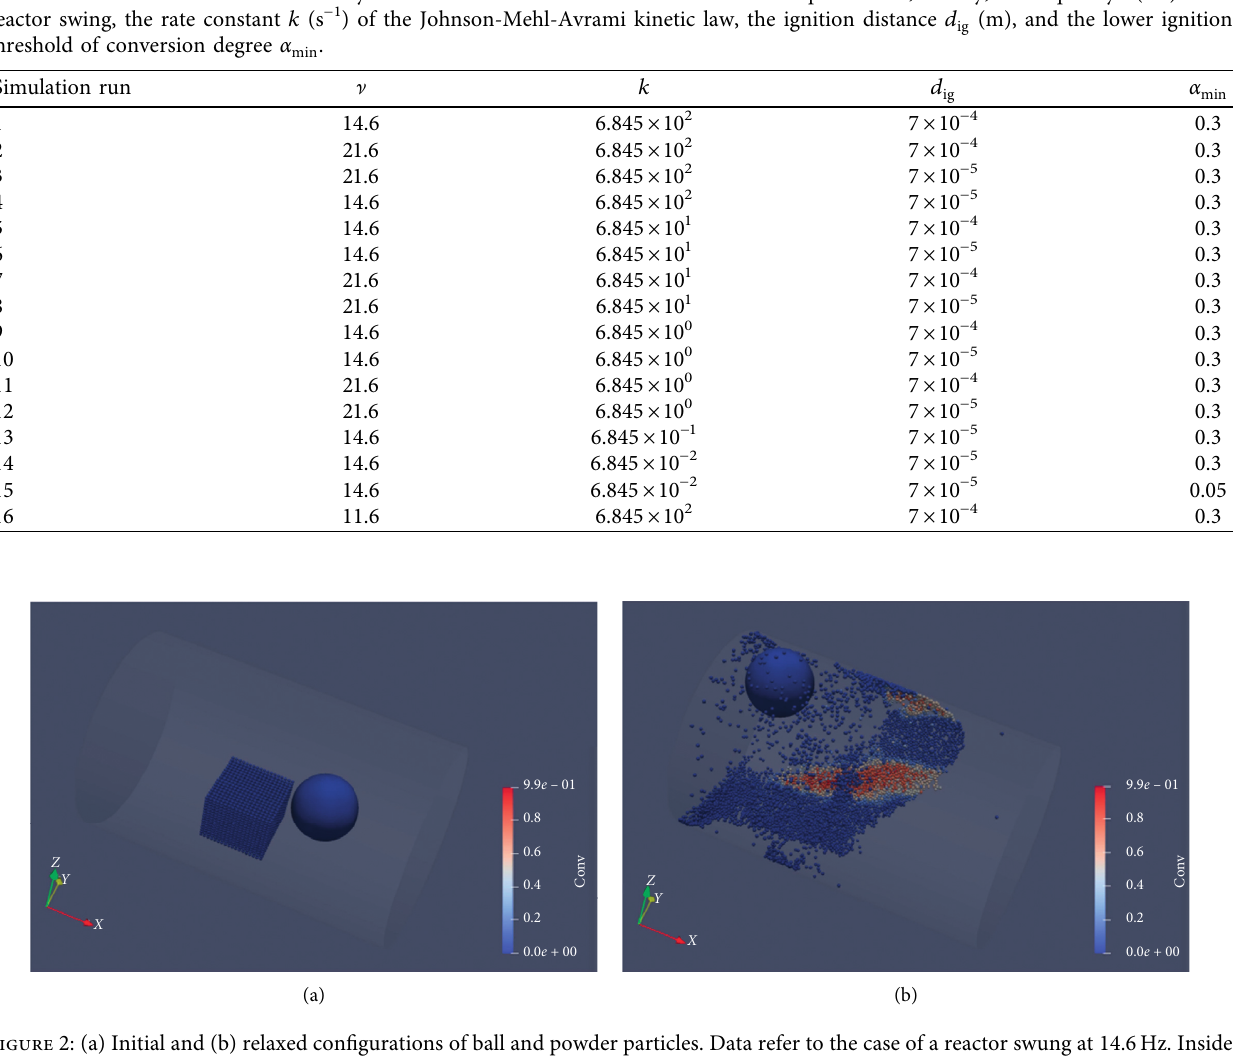
Figure 2: (a) Initial and (b) relaxed configurations of ball and powder particles. Data refer to the case of a reactor swung at 14.6Hz. Inside the reactor, an MSR is propagating. The colour of individual powder particles measures the degree of chemical conversion (blue—low conversion degrees; red—high conversion degrees).